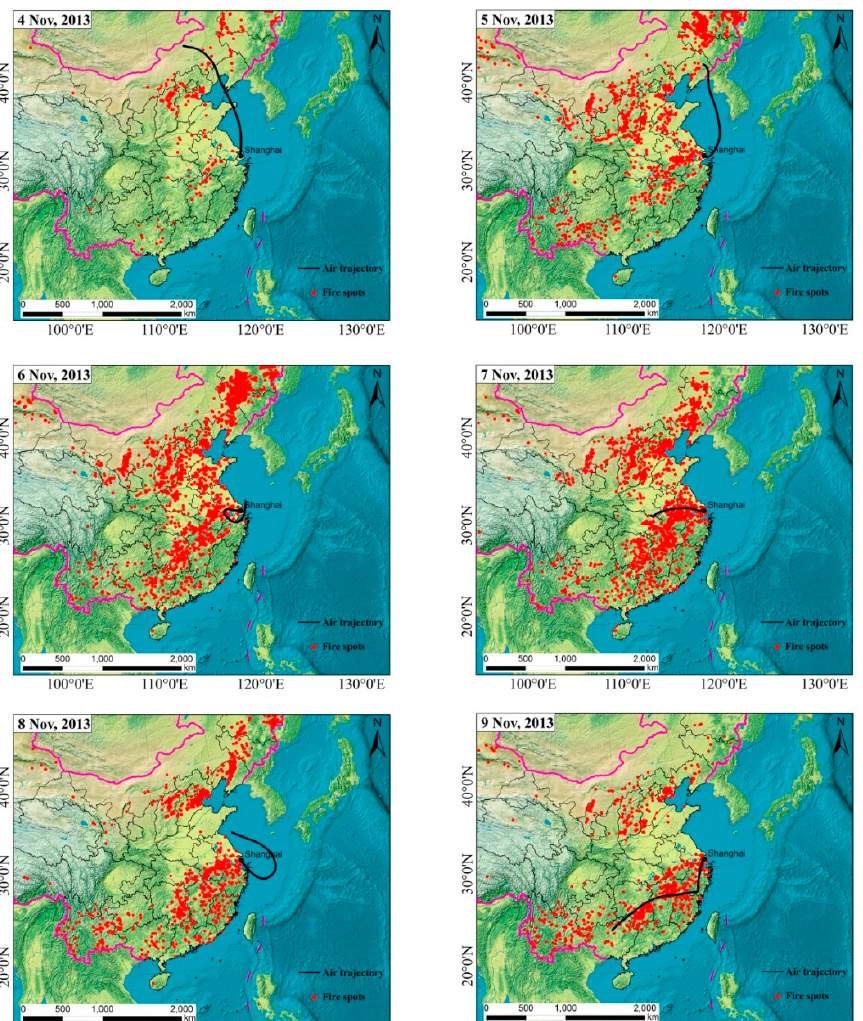
Figure 7. Fire spots’ distribution combined with the 48-h backward trajectory analysis during the period.